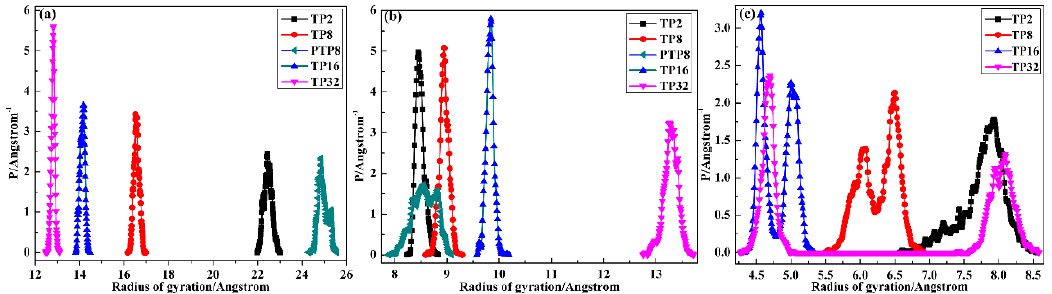
Figure 5. Radius of gyration probability distribution of chains in the layer cell: ( a ) TPU; ( b ) PVAc and ( c ) AO-70.